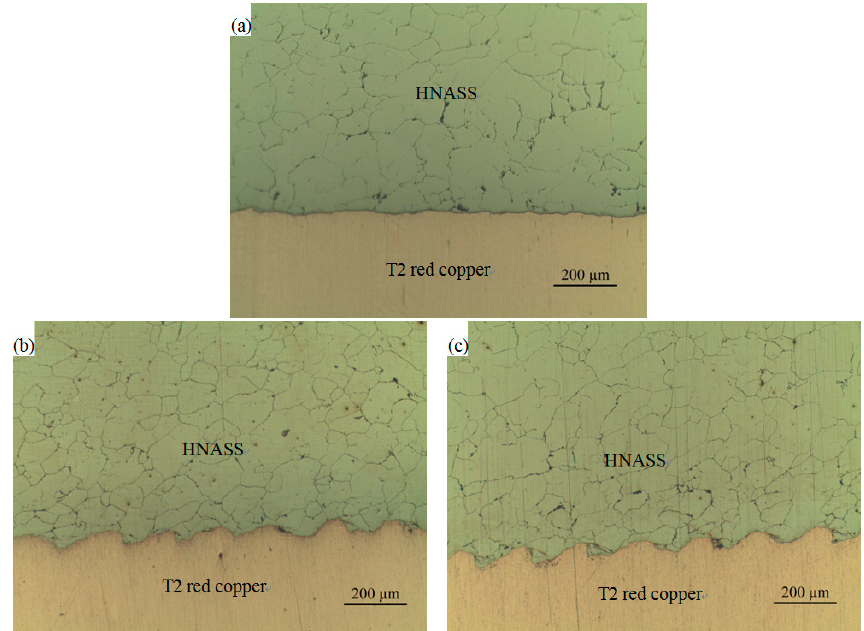
Figure 6. Grains of the parent plate near the joint interface for different explosive ratios. ( a ) R =0.9; ( b ) R =1.1; ( c ) R =1.6.